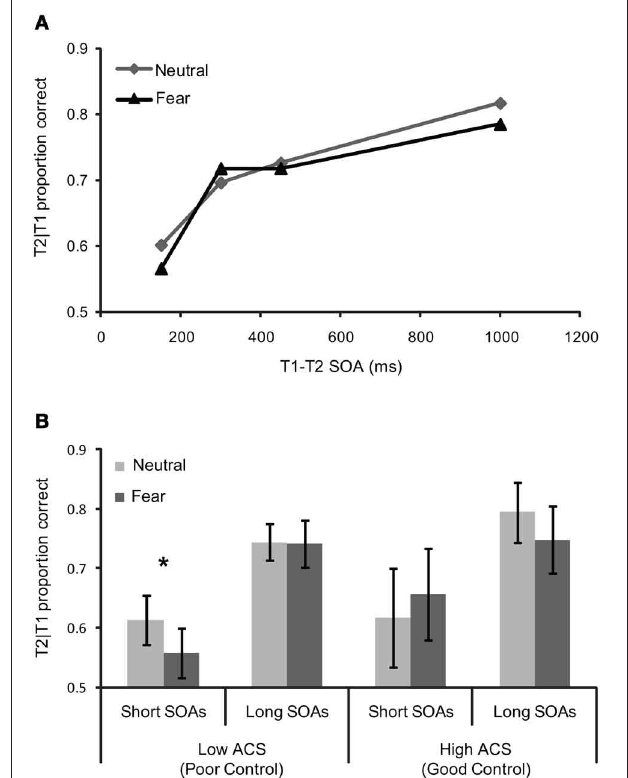
FIGURE 3 | Behavioral performance for (A) whole sample ( n = 19)—T2 scenes task in the dual task condition as a function of the SOA between T1 (the face) and T2 (the scene), and (B) mean T1/T2 performance ( ± S.E.) for short and long SOAs as a function of T1 expression in high ( n = 7) and low ACS ( n = 7) groups. The significant effects are marked with an